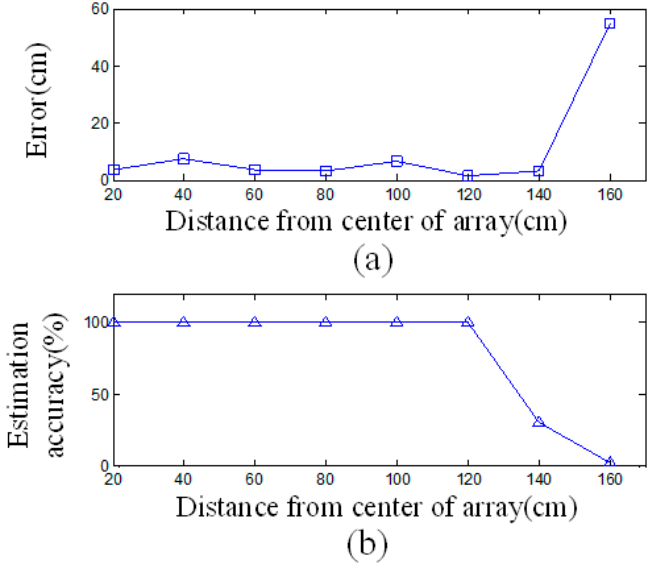
Figure 11. The results with different distances between the target and the center of reference tags array: ( a ) the errors and ( b ) estimation accuracy of targets’ number.